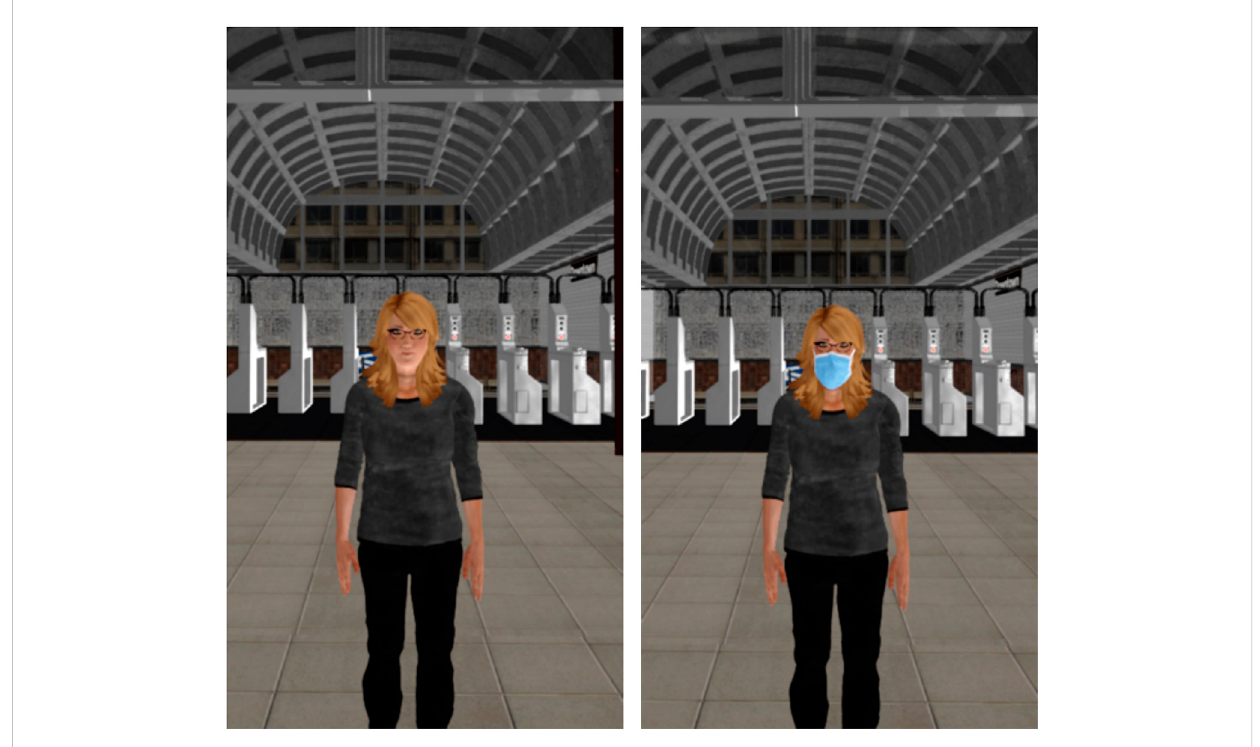
FIGURE 2 Example of a virtual pedestrian (VRP). Unmasked VRP is shown on the left and masked VRP is shown on the